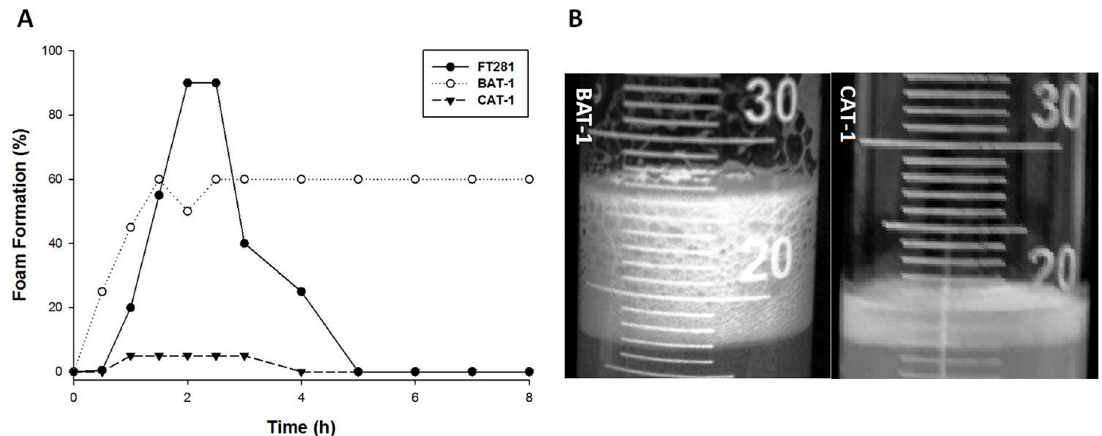
Figure 1. Foam production during fermentation. ( A ) Kinetics of foam formation (volume of foam as a percentage of the media volume) during fermentation of molasses-based medium containing 20 g/L of total sugars by three representative industrial strains. ( B ) Foam produced after 3 h of fermentation by strain BAT-1 (left panel) or strain CAT-1 (right panel).